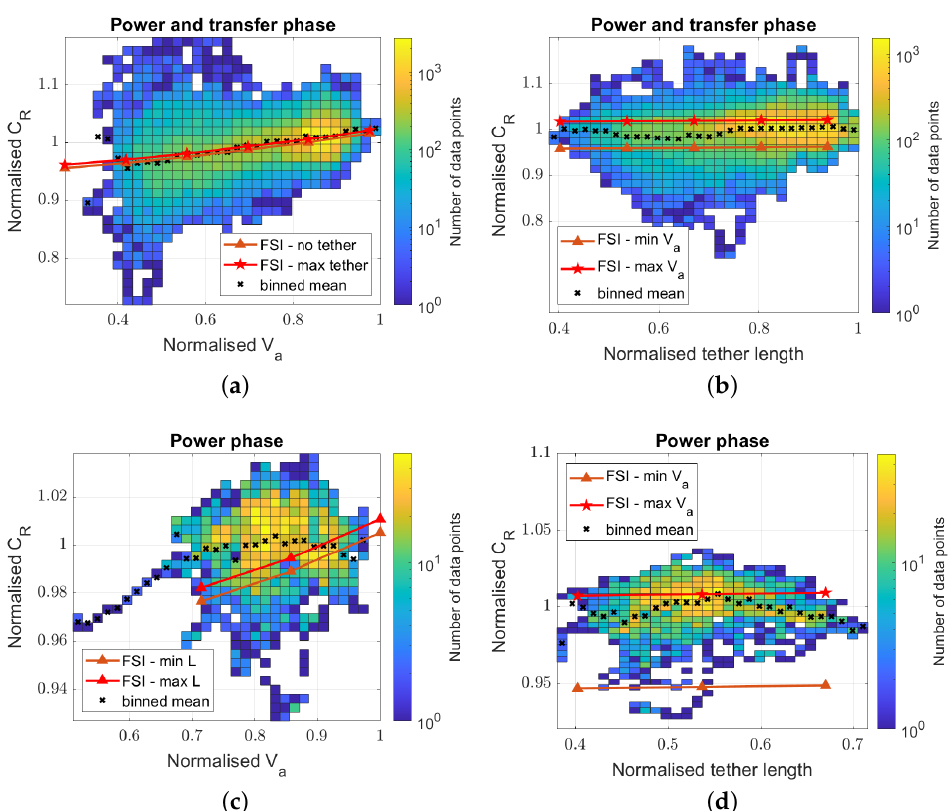
Figure 10. Normalized tether force coefficient for various apparent wind speeds and tether lengths obtained during a total of 154 power cycles [20]. ( a ) C R against V a . ( b ) C R against tether length. ( c ) C R against V a . ( d ) C R against tether